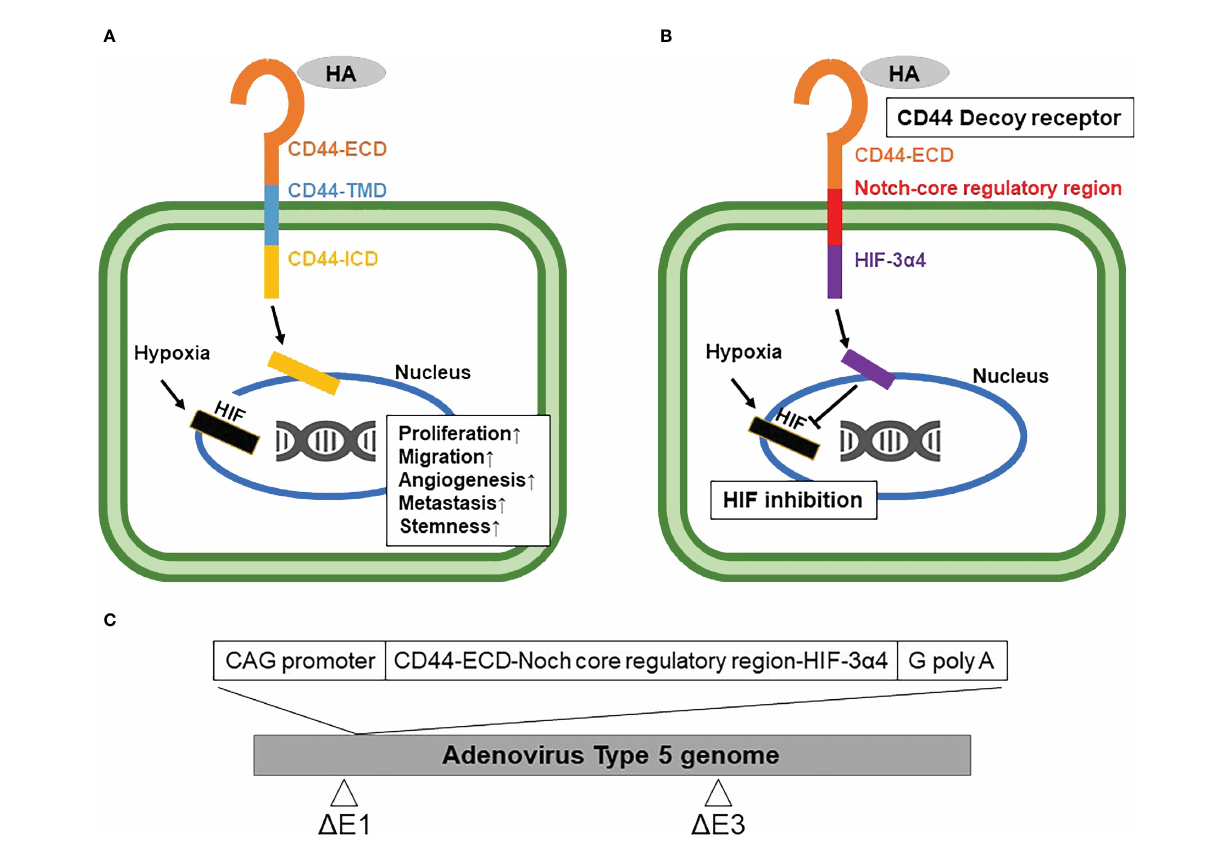
FIGURE 1 Mechanism of synthetic Notch (synNotch) receptor (CD44-N-HIF3 a 4) and construction of Ad-CD44-N-HIF3 a 4 (A) CD44 protein: Hyaluronic acid (HA), a ligand of CD44-extracellular domain (CD44-ECD), initiates the CD44 signaling cascade and then induces the cleavage of the intracellular domain of CD44 (CD44-ICD). CD44-ICD moves into the cell nucleus to promote tumor cell proliferation, migration, angiogenesis, and metastasis. (B) synNotch receptor (CD44-N-HIF3 a 4): Hypoxia-inducible factor (HIF) in hypoxic tumor microenvironments also activates the transcription of various hypoxia target genes promoting tumorigenesis and cancer stemness. Ad-CD44-N-HIF3 a 4 contains a gene encoding a synNotch receptor (CD44-N-HIF3 a 4) composed of the CD44-ECD and HIF-3 a 4 connected by the Notch core regulatory region. CD44-ECD in the synNotch receptor acts as a decoy receptor for the endogenous CD44 protein in the tumor microenvironment. The signal of CD44-ligands such as HA is converted via the Notch core regulatory region at the cell membrane and inhibits hypoxia-induced responses by HIF-3 a 4, which is released from synNotch receptor. (C) Construction of recombinant replication-de fi cient adenoviral vector, Ad-CD44-N-HIF3 a 4 A synthetic fusion gene encoding a synNotch receptor composed of the extracellular domain of CD44 (CD44-ECD) and HIF-3 a 4 connected by the Notch core regulatory region was introduced into the D E1 region of the adenovirus type 5 vector to construct a recombinant replication-de fi cient adenoviral vector, Ad-CD44-N- HIF3 a 4. HA, Hyaluronic acid; ECD, Extracellular Domain; TMD, Transmembrane Domain; ICD, Intracellular Domain; HIF, Hypoxia-inducible